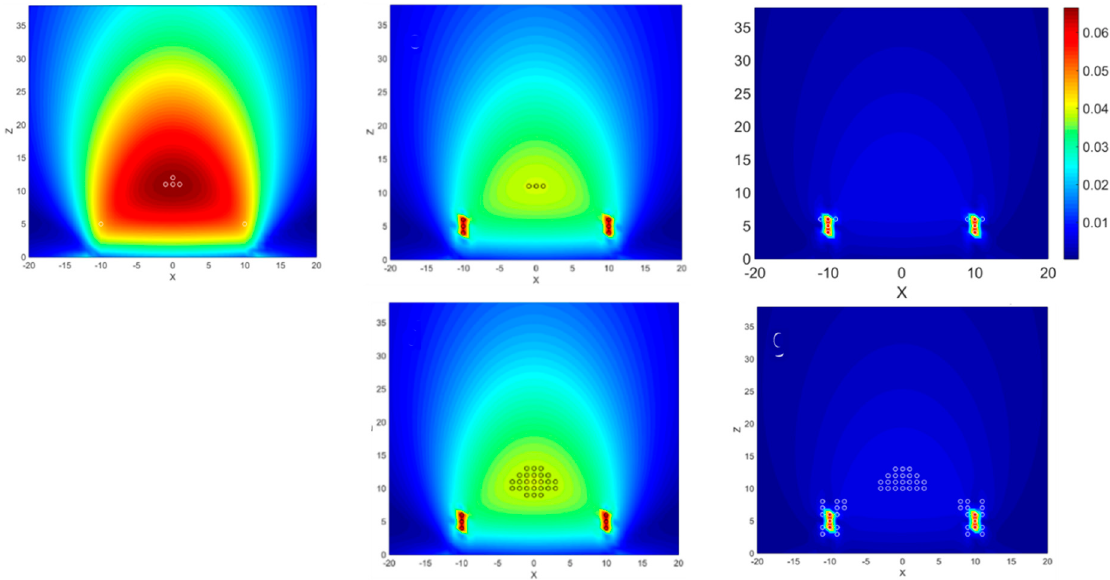
Figure 4. Deviatoric strain and position of the inclusions (white or black circles). Top: at the first deformation step, for n sites = 10 new inclusions per step, without pre-existing defects at the surface ( left ), with pre-existing defects at the surface shown as Eshelby inclusions with the shear eigenstrain ε xy = 1.01 ε d max ( middle ), and with pre-existing defects at the surface shown as Eshebly inclusions with the shear eigenstrain ε xy = 10.1 ε d max ( right ). Bottom: at step 10 of the deformation (n sites = 10) with pre-existing defects with the shear eigenstrain ε xy = 1.01 ε d max ( left ) and ε xy = 10.1 ε d max ( right